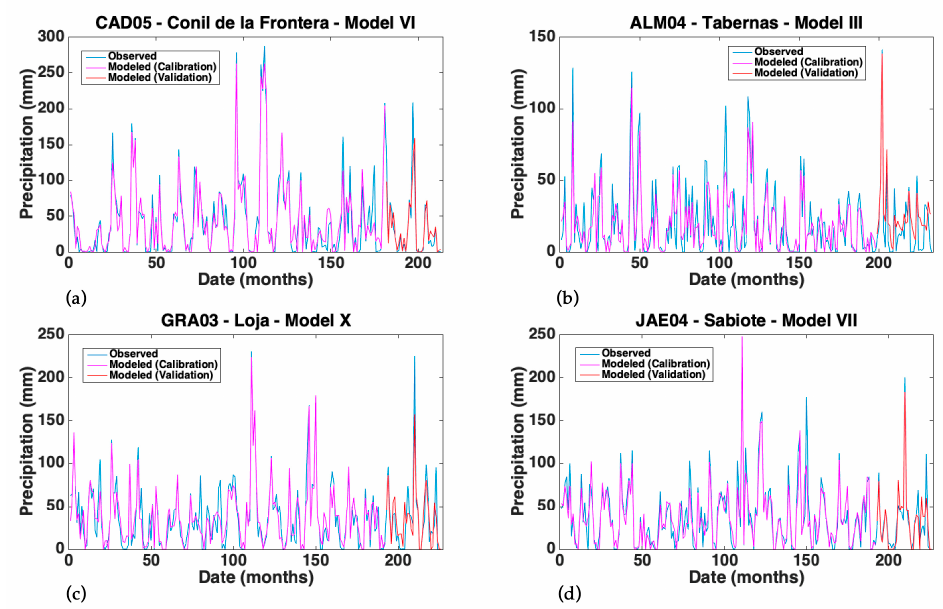
Figure 7. Plot of measured and forecasted monthly precipitation at four stations: Conil de la Frontera ( a ), Tabernas ( b ), Loja ( c ) and Sabiote ( d ) using Models VI, III, X and VIII, respectively.